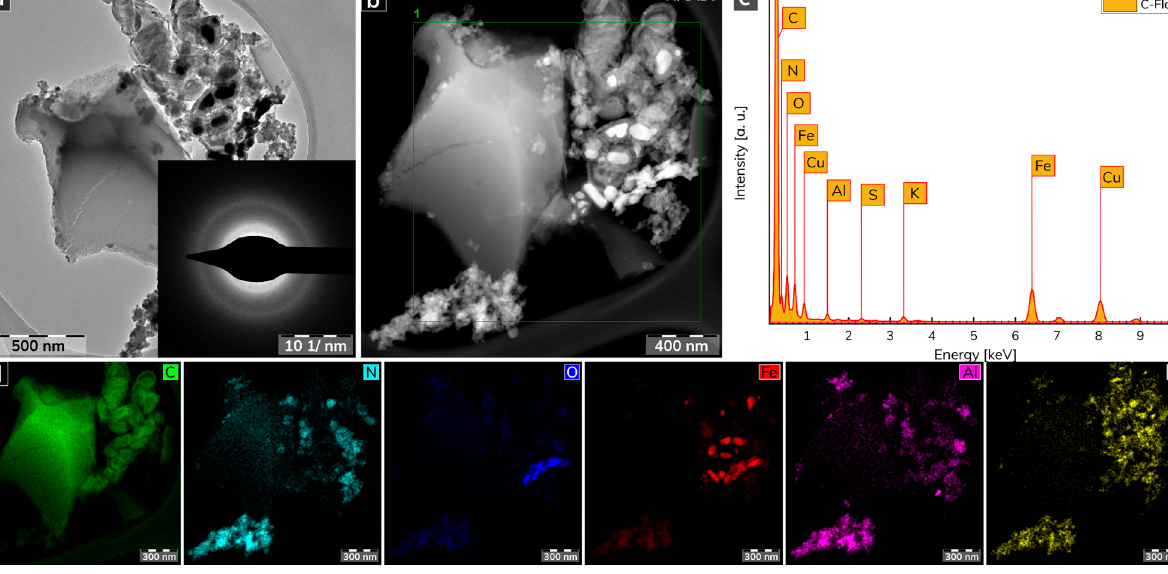
Figure 2. ( a ) HRTEM image of a C-Flax sample. ( b ) Darkfield HRTEM image used for EDS chemical mapping. ( c ) EDAX spectrum of C-Flax sample. ( d ) EDS elemental mapping of C-Flax sample, including carbon, nitrogen, oxygen, iron, aluminum, and potassium atoms. Scale bars were unified from the graphical point-of-view to provide better visibility.